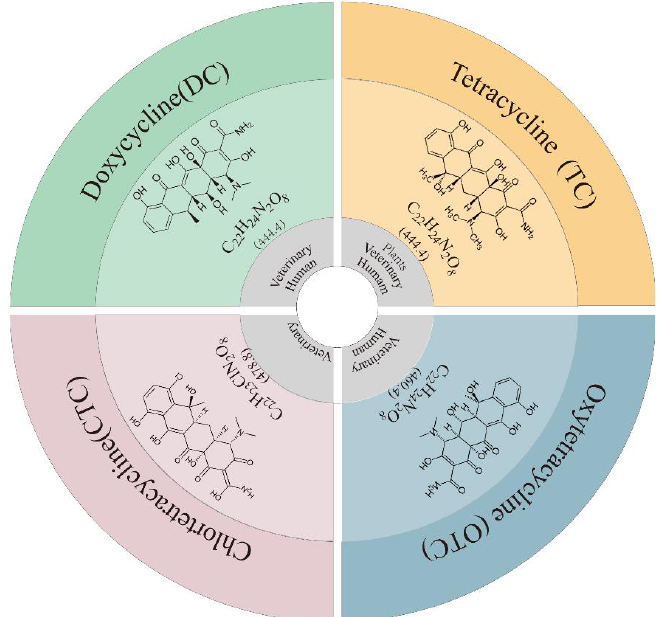
Figure 1. Physical and chemical properties of TCs. Outermost circle is name and abbreviation; middle is structural formula, molecular formula and molecular weight; and inner circle is main use.